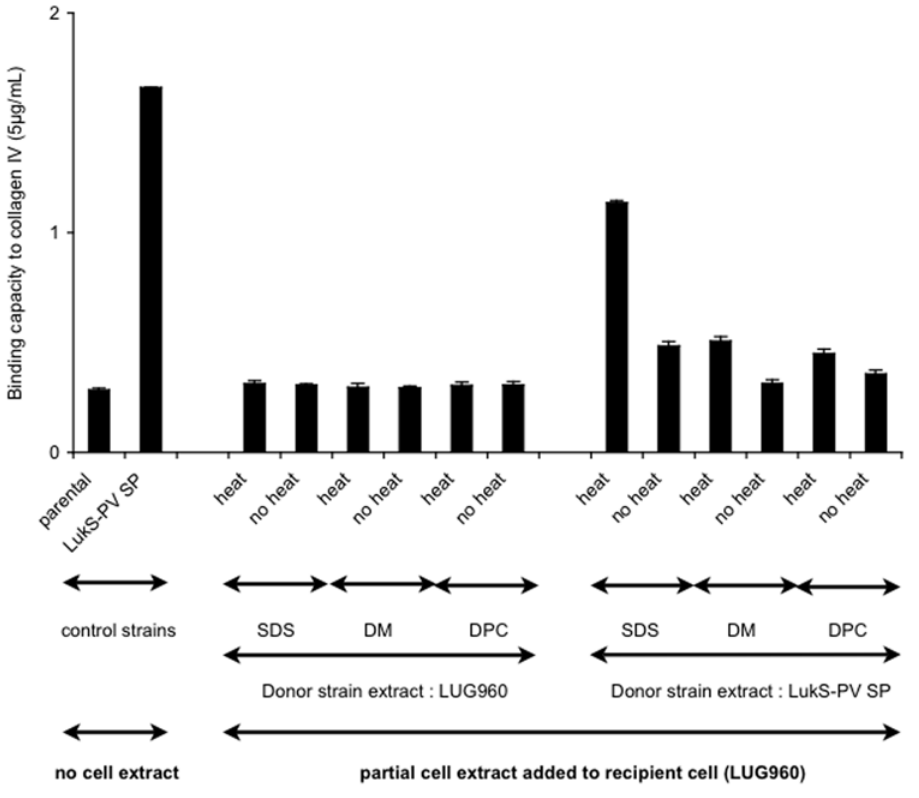
Figure 8. Adherence is mediated by cell wall associated material. Following overnight culture and centrifugation, the bacterial pellet of the donor strain (parental or parental carrying a plasmid expressing LukS-PV signal peptide) was resuspended in 1 mL extraction buffer (2% SDS or DM or DPC), heated (or not) at 95 u C for 2 min, and centrifuged. The supernatants were used to resuspend the bacterial pellet of the recipient strain to be tested (parental) in the adherence assay to type IV collagen (5 m g/mL, Sigma) coated on 96-well plates. The first two lanes are control strains (parental and parental expressing LukS-PV signal peptide) with no cell extract added. All other lanes indicate the various conditions of cell extracts added to the parental. The vertical lines indicate the standard deviations.